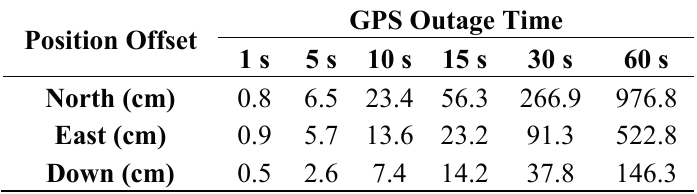
Table 3. Performance of INS-only positioning by using tactical IMU (POS310).